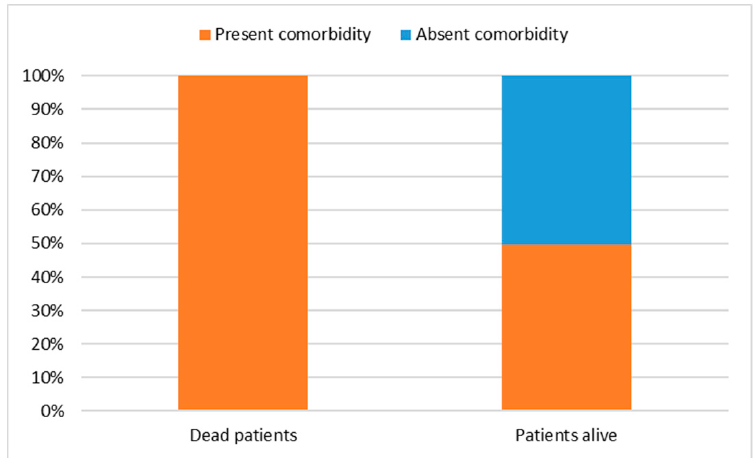
Figure 3. Association between ARDS hospitalization outcome and comorbidity.